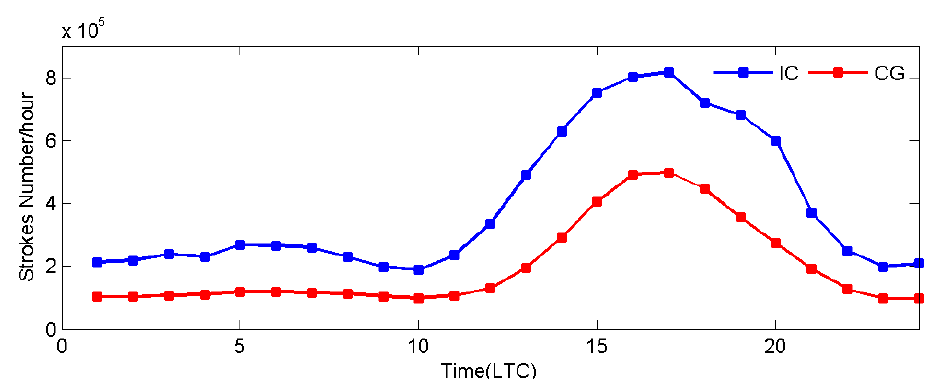
Figure 12. The average distribution of lightning hourly frequency in one day.